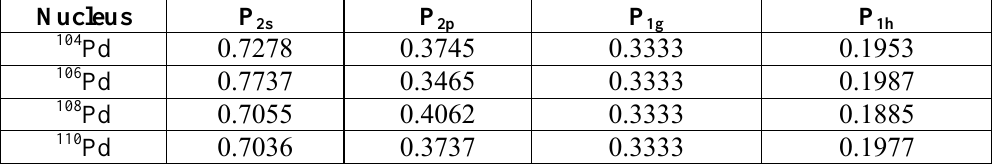
Table 2: The occupation probabilities of the shell 2s, 2p, 1g and 1h of the